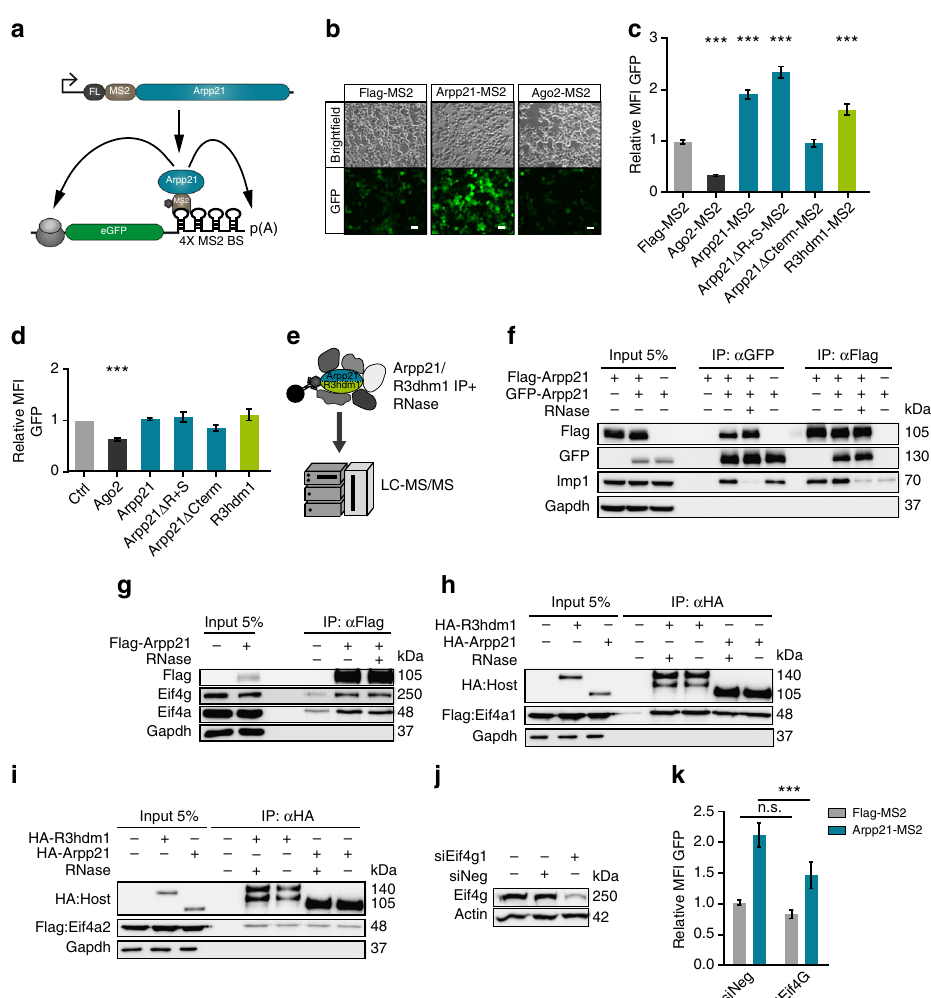
Fig. 3 ARPP21 acts as a positive regulator of post-transcriptional gene expression in a tethering assay and functionally interacts with parts of the eIF4F complex. a The MS2 coat protein was used to tether ARPP21 to the 3 ′ UTR of a GFP reporter transcript in 293T cells. b ARPP21 tethering results in increased GFP fl uorescence of the MS2-binding site reporter (4X-MS2-BS-GFP) compared to tethering of the MS2 protein alone. Tethering of the translational inhibitor AGO2 decreases basal GFP fl uorescence. Scale bar: 50 µ m. c Flow cytometry analysis of tethering assays, expressed as mean fl uorescent intensity (MFI) of transfected cells. AGO2-MS2 decreases, and ARPP21-MS2 and R3HDM1-MS2 increase the expression of the 4X-MS2-BS- GFP reporter, relative to Flag-MS2 alone. The C-terminal part of ARPP21 is necessary and suf fi cient for the positive effect on reporter expression. *** p < 0.001, Student ’ s t -test, n = 3, error bars represent ± s.d. d Untethered ARPP21 and R3HDM1 have no signi fi cant effect on GFP expression from the 4X- MS2-BS-GFP reporter relative to MS2 control. Statistical analysis as in c , n = 3. e FLAG-tagged ARPP21 or R3HDM1 were immunoprecipitated from 293T lysates after RNase digestion and protein interactors were identi fi ed by LC-MS/MS. f Co-immunoprecipitation (co-IP) using FLAG- or GFP-tagged ARPP21 constructs verify the ability of ARPP21 to self-interact by reciprocal co-IP. RNAse treatment strongly reduces co-IP of the RNA-binding protein IMP1 but not homomeric ARPP21 interactions. Loss of GAPDH protein after IP is shown as control. g FLAG-ARPP21 coimmunoprecipitates endogenous eIF4A and eIF4G from N2A cells. Antibodies used for detection of proteins in input and eluate are shown on the left. RNase pretreatment of lysates had no effect on co-IP of eIF4A or eIF4G. h , i ARPP21 and R3HDM1 coimmunoprecipitate eIF4A1 more ef fi ciently than eIF4A2. HA-tagged ARPP21 or R3HDM1 was co-transfected with FLAG-tagged eIF4A1 ( h ) or eIF4A2 ( i ); results after immunoprecipitation with anti-HA antibody are shown. j Validation of endogenous